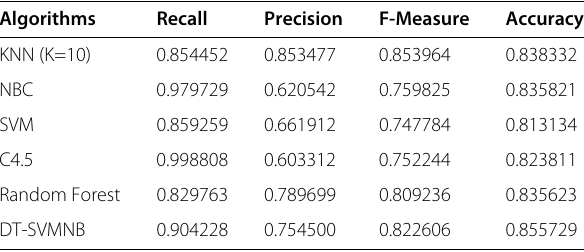
Table 5 Accuracy Comparison for Anomalous User Detection on